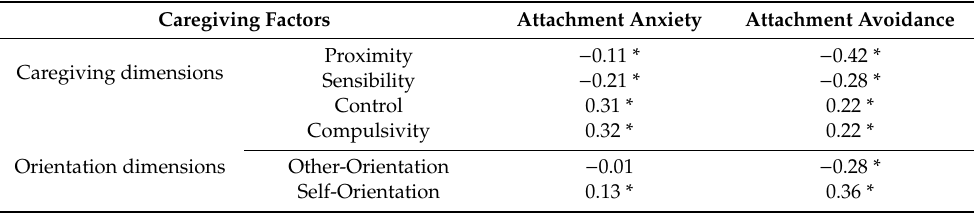
Table 5. Correlation of caregiving dimensions and attachment